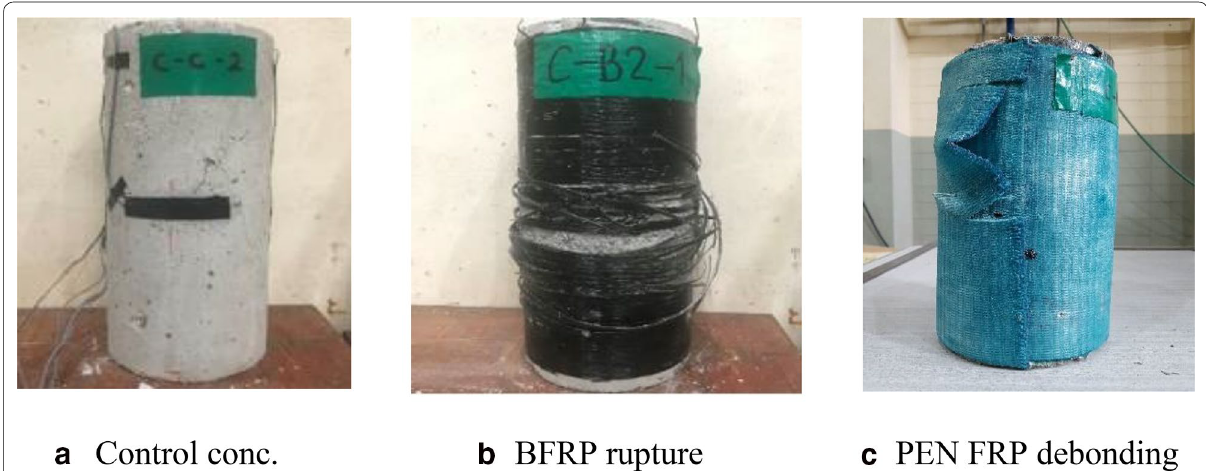
Fig. 15 Failure mode of Control and BFRP- and PEN FRP-confined cylinders: main confinement